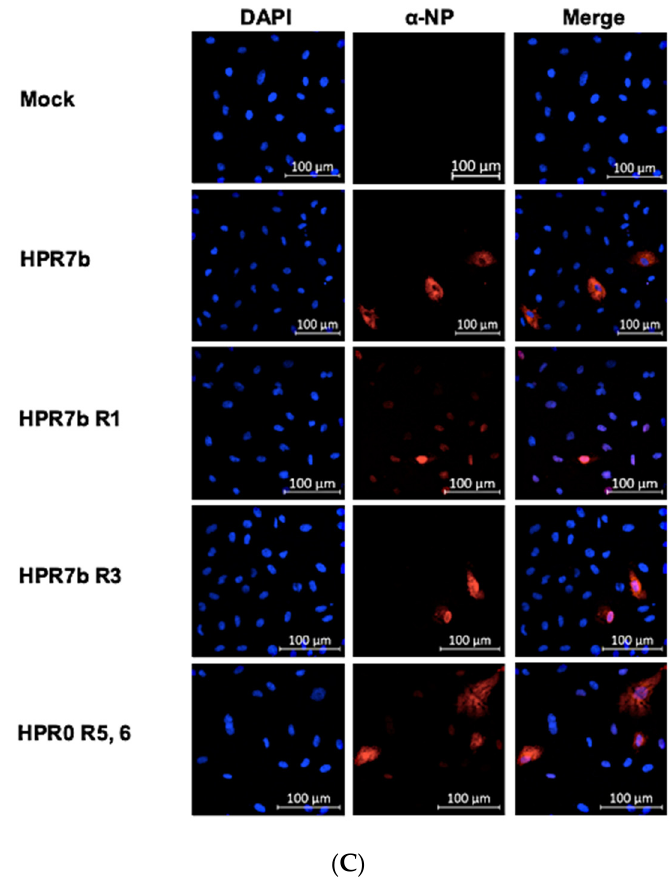
Figure 5. rISAV infection assays in RTG-2 and CHSE-214 cells. RTG-2 and CHSE-214 cells were infected at an MOI of 0.1, and viral titers were recorded at 0 and 7 dpi by qRT-PCR. Viruses showing replication activity in CHSE-214 cells were assessed via indirect immunofluorescence. ( A ) Infection kinetics of reassortant viruses in RTG-2 cells at 0 dpi (black) and 7 dpi (grey). ( B ) Infection kinetics of reassortant viruses in CHSE-214 cells at 0 dpi (black) and 7 dpi (grey). ( C ) Immunofluorescence detection of ISAV NP protein in infected CHSE-214 cells that were incubated with each virus showing replicative activity in ( B ); NP viral protein was detected at 5 dpi using a monoclonal anti-NP primary antibody and an anti-mouse Alexa Fluor 594-conjugated secondary antibody (red). Cellular DNA was stained in the nucleus with DAPI (blue). Uninfected control cells are included (mock). Viral titers ± SEM from three independent experiments. α = 0.05; ** p < 0.005; *** p < 0.0005; **** p < 0.00005. Scale Barr: 100 µM.